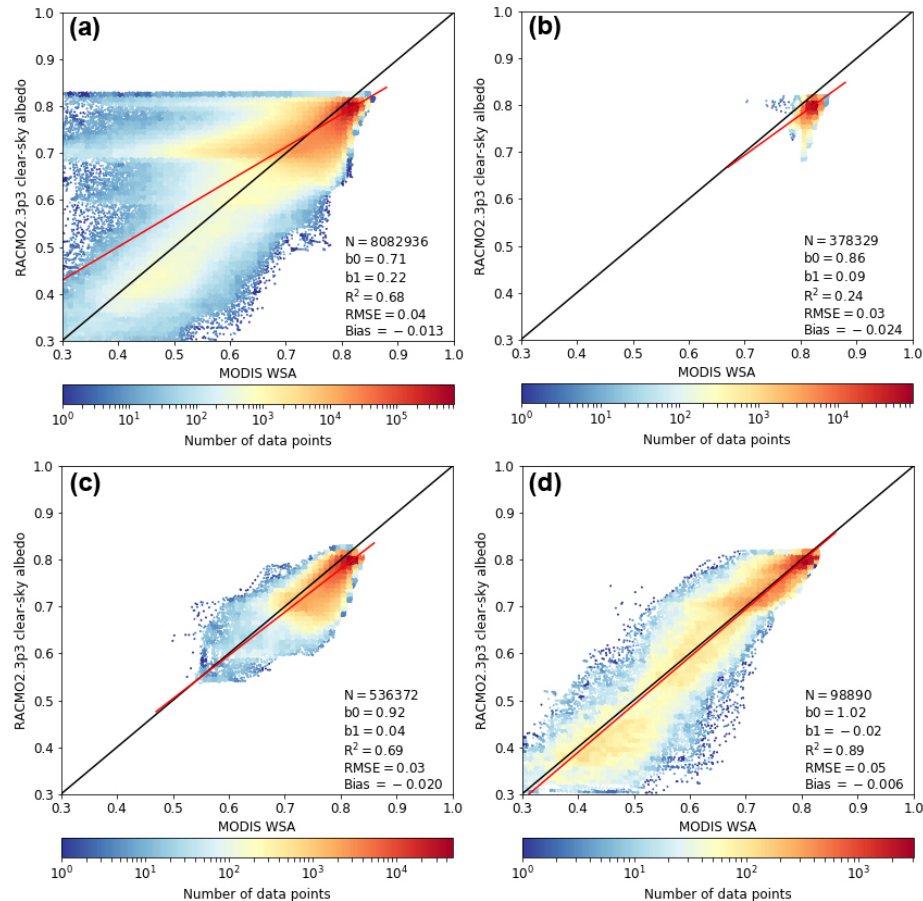
Figure 3. Comparison between 16d running mean RACMO2.3p3 clear-sky albedo and MODIS MCD43A3 CSD albedo. Every data point represents an observation at a grid point at 15:00UTC for a day between 2006 and 2015. In black the 1-to-1 line. The red line is the linear regression of the data, with b0 the slope and b1 the intercept. In addition, number of records ( N ), correlation coefficient ( R 2 ) and root-mean- square error (RMSE) are displayed. Colors indicate number of data points, and the bin size is 0.01. (a) displays data for the whole domain; (b) , (c) and (d) display the brown, green and pink boxes in Fig. 2c,